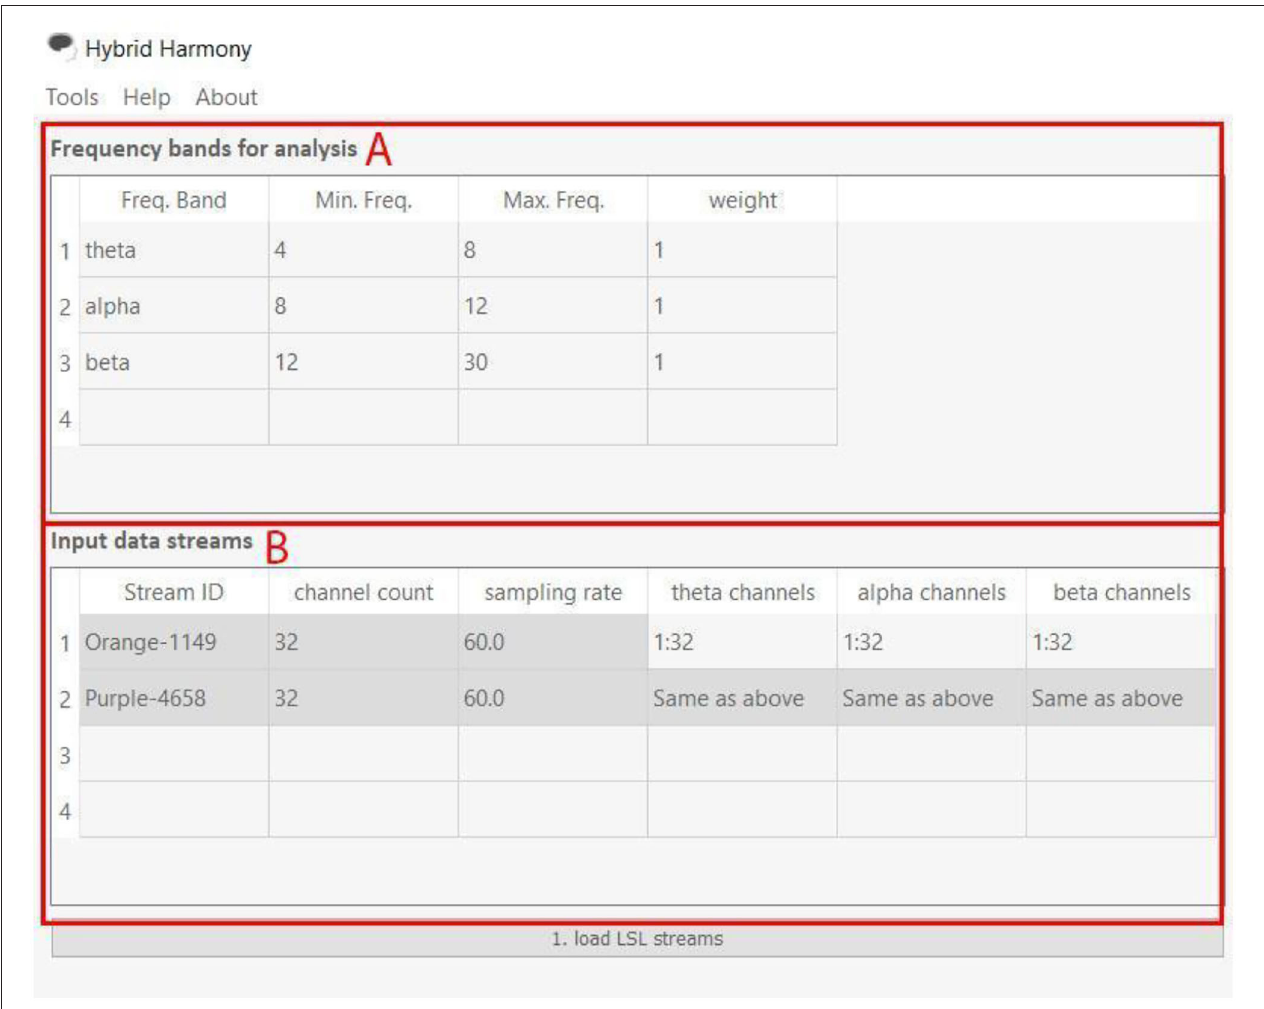
FIGURE 4 | Frequency bands for analysis and Input data streams of the Hybrid Harmony GUI. The left half of the GUI, i.e., the “Frequency bands for analysis” and “Input data streams” tables control parameters for data preprocessing (section Data Preprocessing). (A) “Frequency bands for analysis” has four editable columns: Freq. Band: Name of the frequency band; Min. Freq.: The lower bound frequency for the band; Max. Freq.: The upper bound frequency for the band; weight: Weighting factor of the current band (connectivity values will be multiplied by this factor). (B) “input data streams” has three non-editable columns: Stream ID: Name of the EEG stream; channel count: number of EEG channels; sampling rate: sampling rate of the EEG streams. It also has editable columns, corresponding to frequency band names that users typed in (A) . The columns theta channels, alpha channels, and beta channels thus determine channel indices to use for computing connectivity